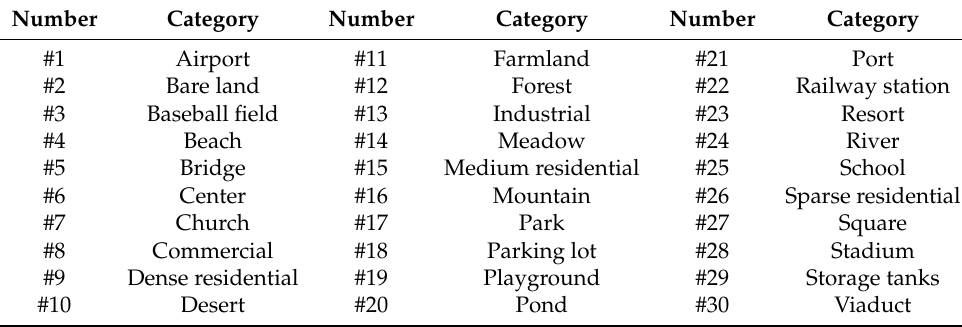
Table 3. The number of features and categories on the AID